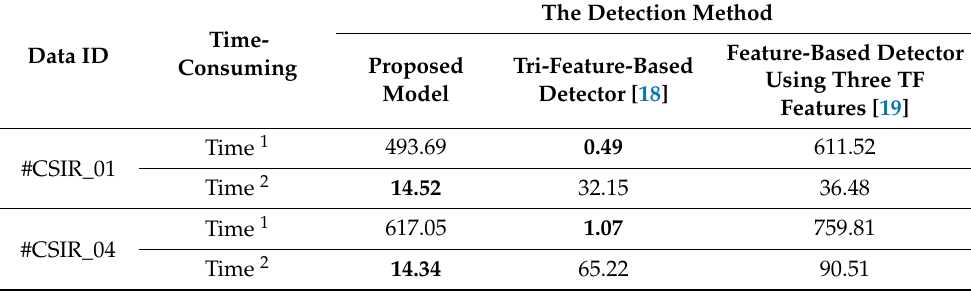
Table 5. Time consumption of different detection methods for the data of #CSIR_01 and #CSIR_04. The radar observation time is 0.512 s. The probability of false alarm is 10 − 3 . Bold highlights the comparison